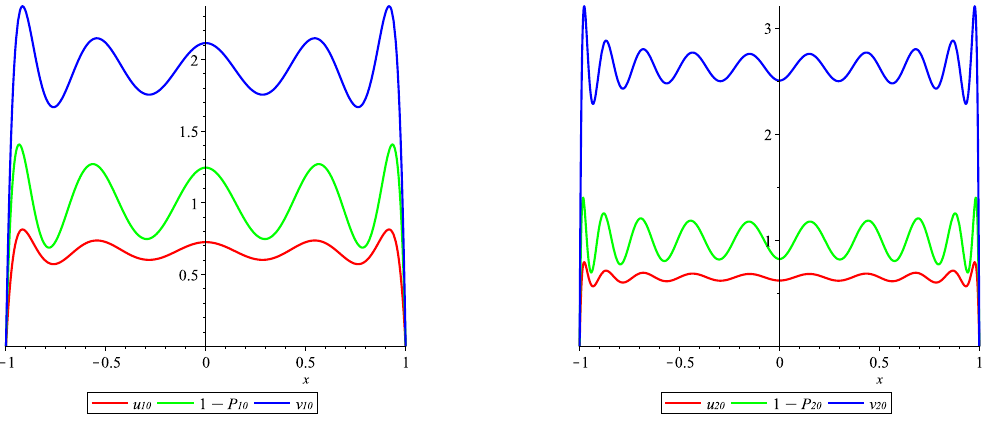
Figure 1. Graphs of u n , v n and 1 − P n